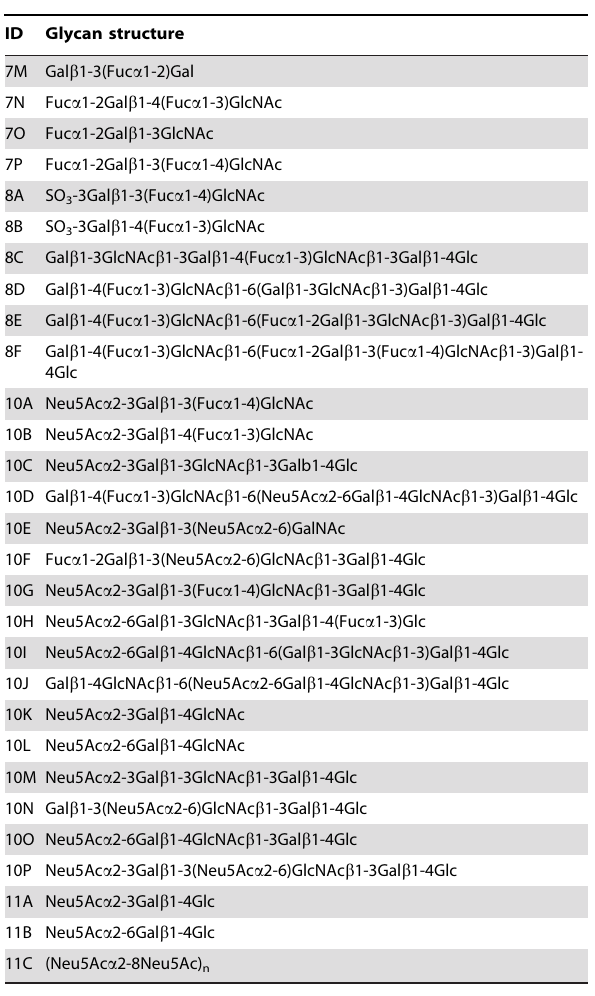
Table 2. Glycan structures present on array.